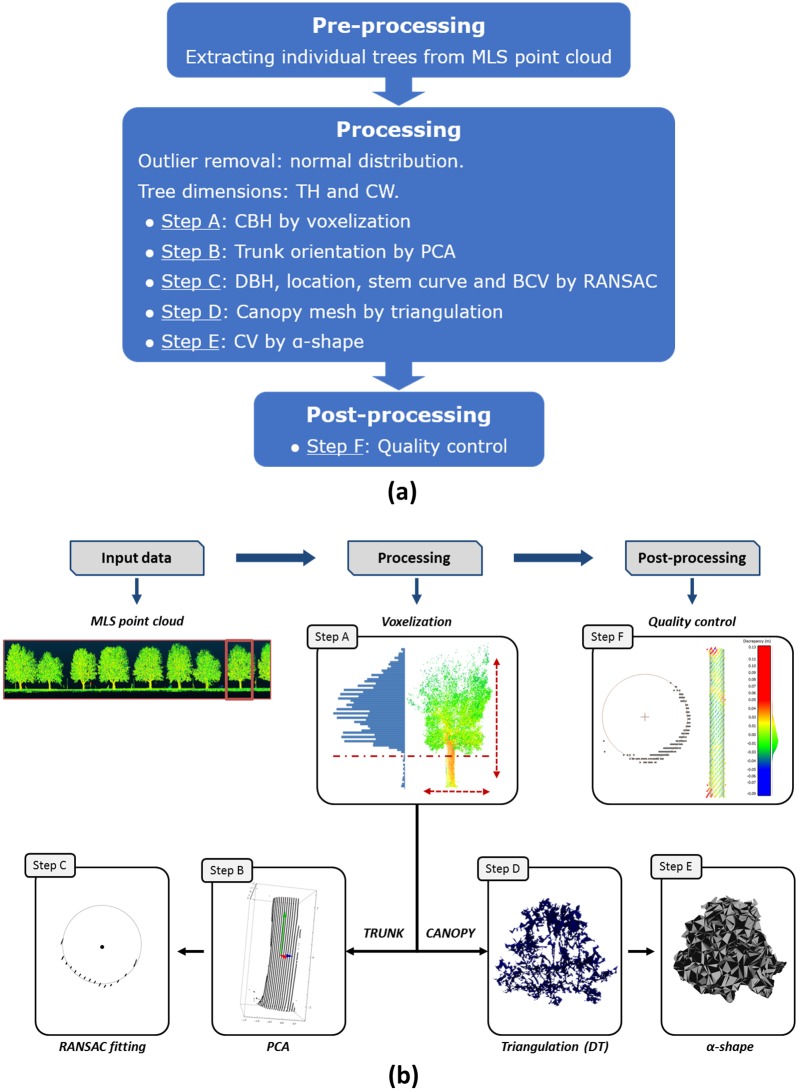
Workflow of the methodology for structural tree parameter extraction; scheme (Fig 3a) and illustrated workflow (Fig 3b).